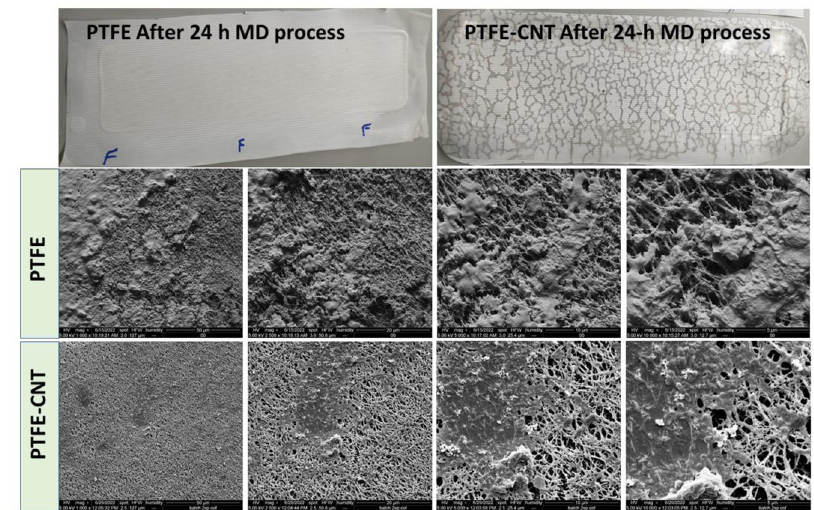
Fig. 4 Photo images and FESEM images of PTFE and PTFE-CNT membranes after 24-h DCMD